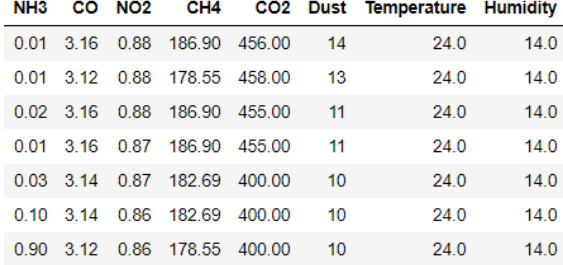
Figure 13. Fragment of Collected